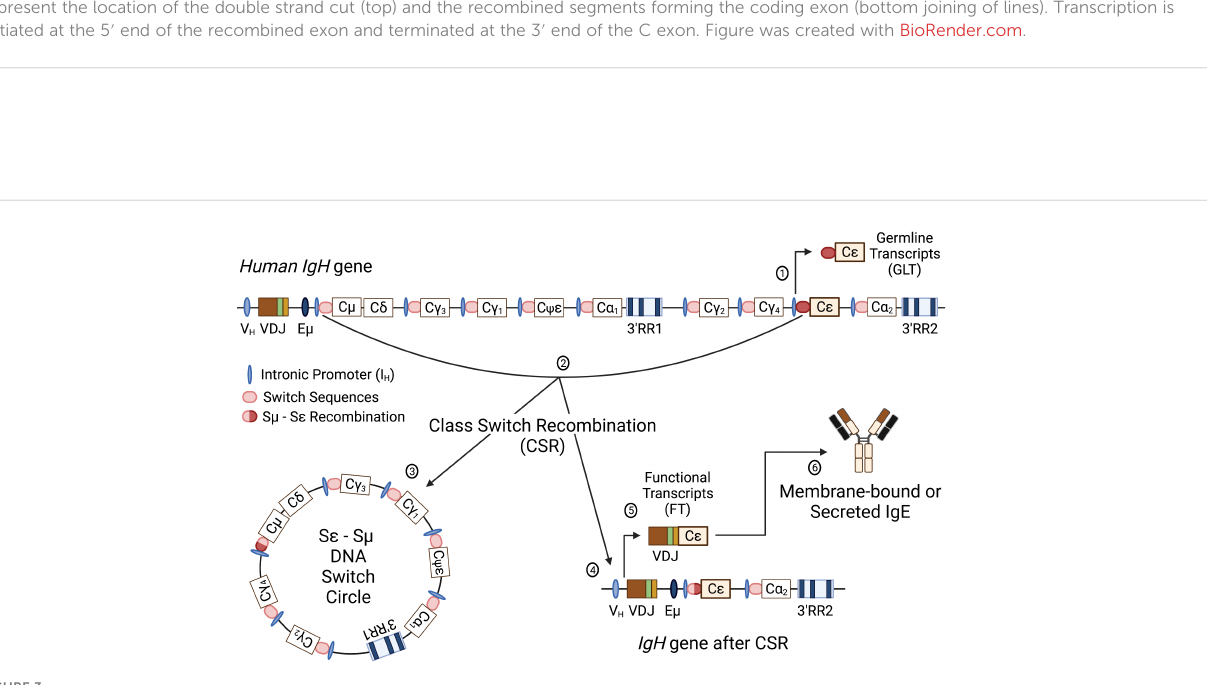
FIGURE 3 Schematic of the human IgH gene locus and class switch recombination. The human recombined IgH gene contains a variable heavy chain promoter (V H ), variable region (recombined VDJ), intronic enhancer (E m ), constant regions for all antibody isotypes (C m , C d , C g 1-4 , C e , C a 1,2 ; C ye is a nonfunctional pseudogene) and two 3 ’ IgH regulatory regions (3 ’ RR1 and 3 ’ RR2). Immediately upstream of each C H , except d , is an intronic promoter (I H ) and a cytidine- rich switch sequence (S H ). Following successful V(D)J recombination, the fi rst antibody isotypes expressed are IgM and IgD. Class switch recombination (CSR) involves an irreversible DNA recombination of the IgH gene that allows a different constant region to be expressed without changing the antigen recognition. Switch to another isotype is dependent on speci fi c cellular stimuli that targets a speci fi c intronic promoter and induces transcription through the switch region of the targeted constant region. The schematic illustrates CSR to C e to produce IgE. Transcription initiated through the I e produces nonfunctional germline transcripts and opens the chromatin for targeting by activation-induced cytidine deaminase (AID) (1). AID targets the switch sequences upstream of Cµ and the constant region C e , causing nonhomologous recombination between the switch regions (i.e. Sµ and S e ) (2). CSR results in removal of the intervening DNA between the recombined switch sequences (S e -Sµ DNA Switch Circle) (3) and a recombined IgH gene with VDJ linked to C e (4). Transcription of the IgH gene results in functional VDJ-C e transcripts (5) that will be translated into the e heavy chain protein to form IgE antibodies (6). Figure was created with